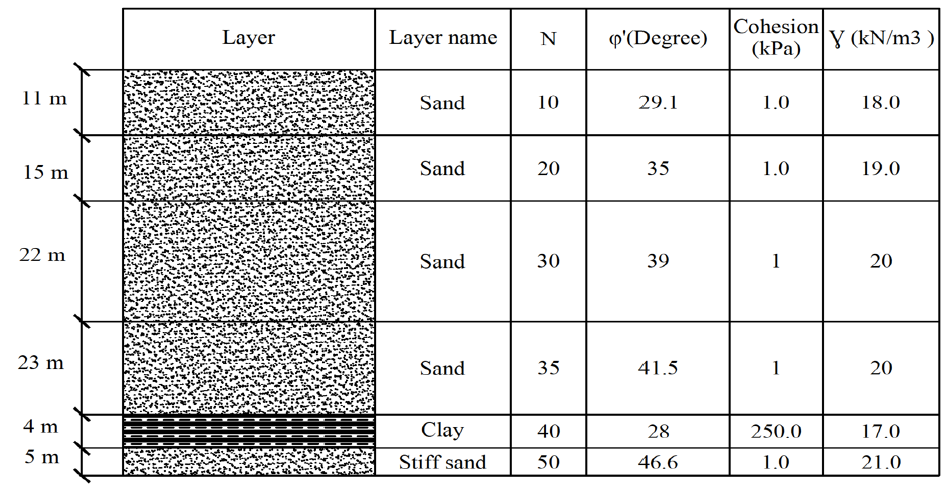
Figure 14. Ground